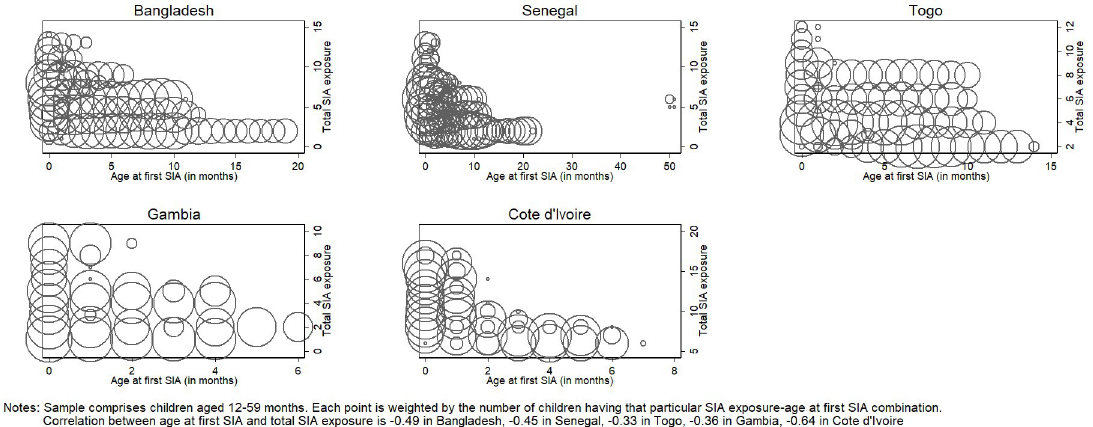
Fig 2. Impact of supplementary immunization activities (SIAs) on routine vaccinations—instrumental variable (IV) first stage.